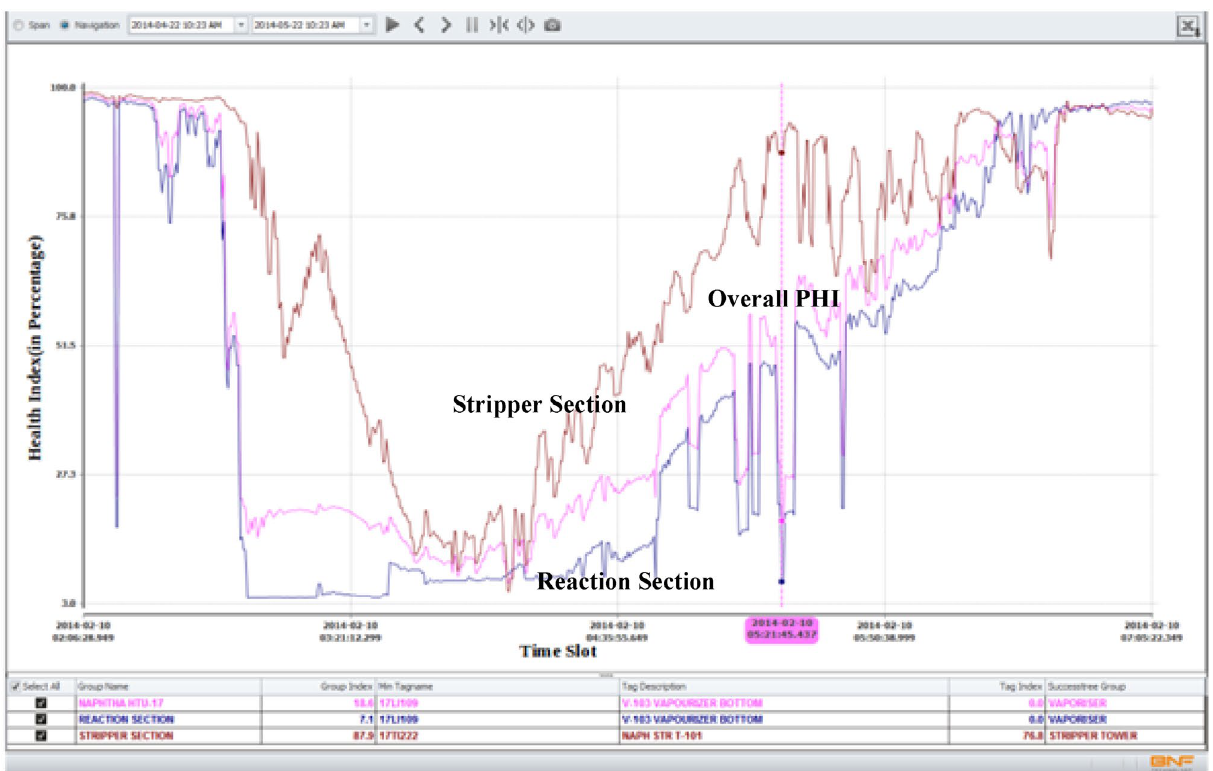
Figure 18. Case 2. Sudden increase in the liquid level resulted in dropping the overall PHI as well as the health indices related to the reaction and stripper